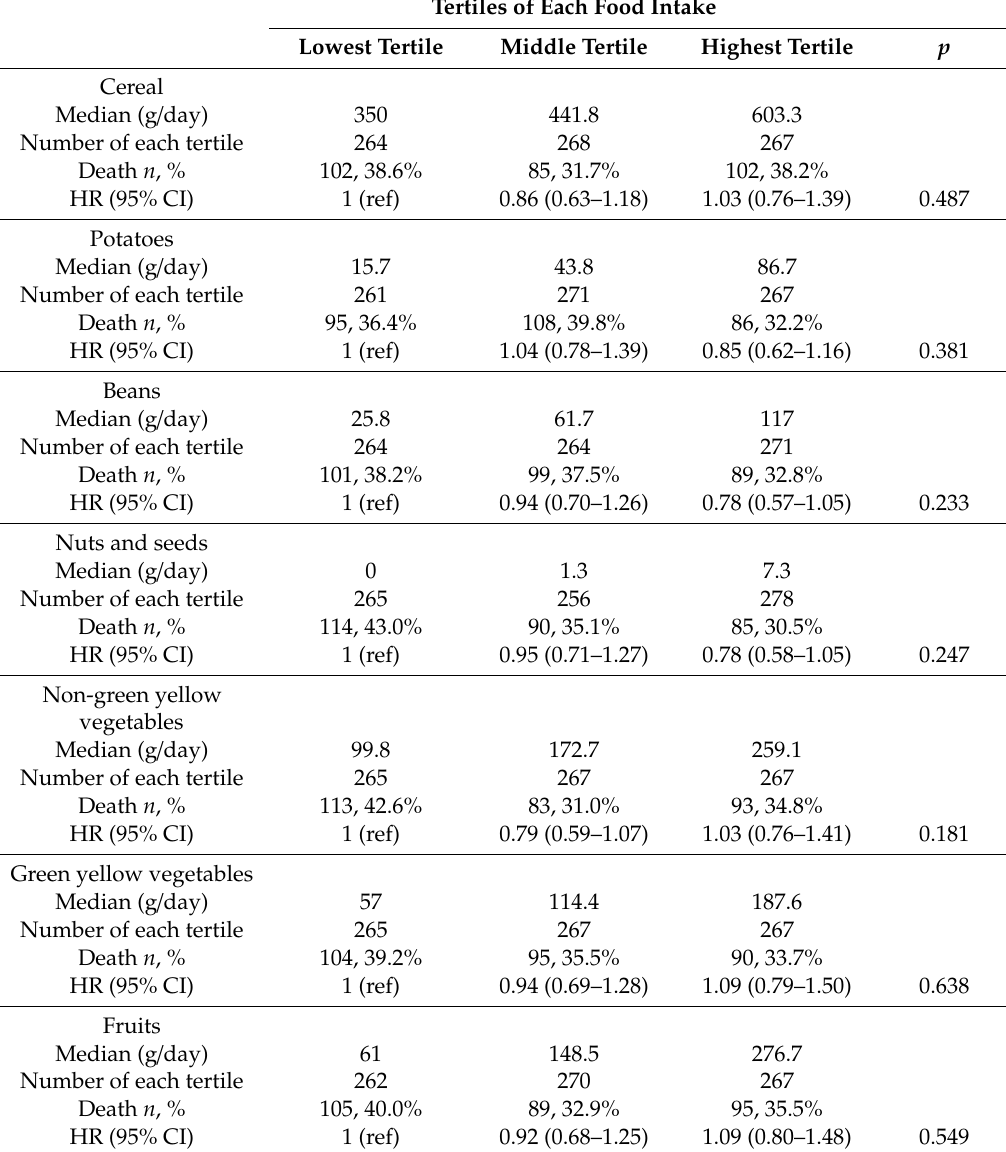
Table 3. Multivariate-adjusted hazard ratios 1 for all-cause mortality, according to the tertiles of each food